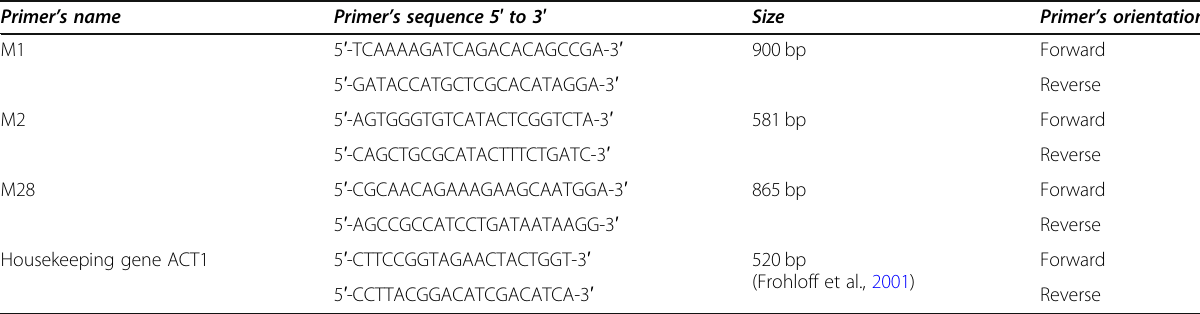
Table 1 Candidate housekeeping gene and their primer sequence for